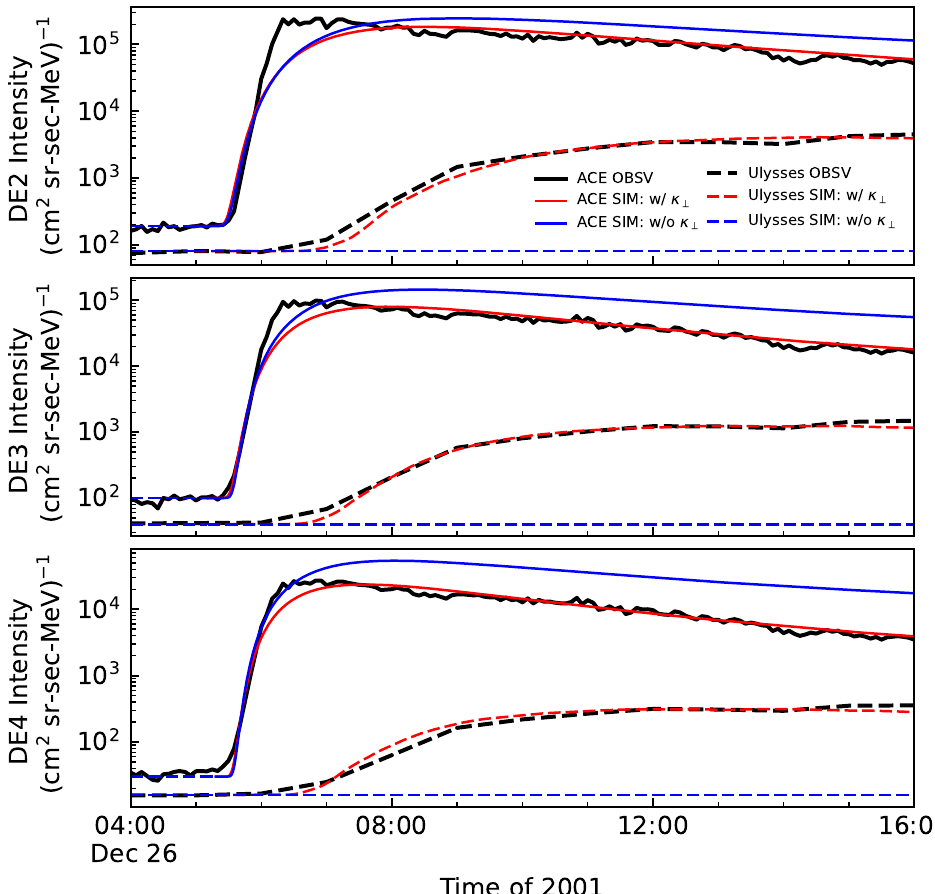
Figure 12. Same as Figure 11, except that simulation results without perpendicular diffusion (blue lines) are added